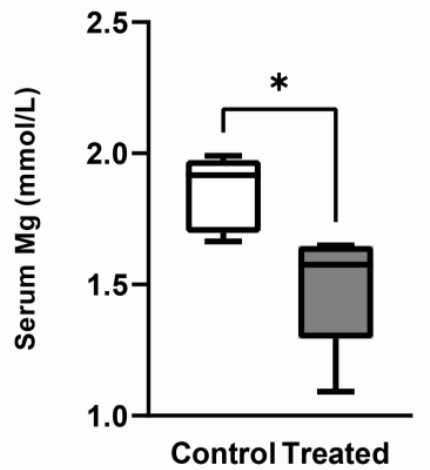
Figure 2. Serum Mg concentration. Mg was measured in serum of mice fed either a normal (control) or a Mg deficient (treated) diet. Data (n = 6 per each group) are presented as box-and-whisker plots- (Center line, median; box limits, first and third quartiles; whiskers, max-min). * Significant differences of the treated group vs. the control group ( p < 0.01).